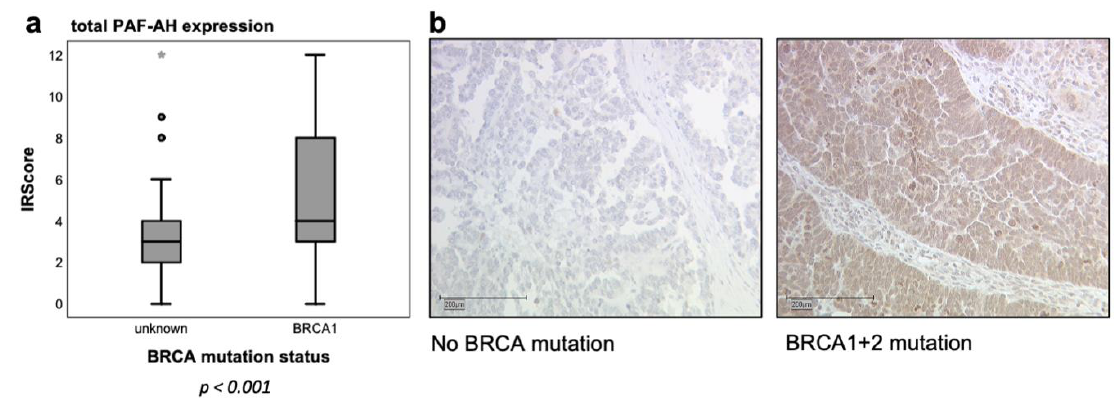
Figure 2. BRCA1 mutation carriers showed higher tumoral PAF-AH expression. PAF-AH expression was significantly higher in tumor tissue of BRCA1 mutation carriers (median IRScore = 4; p < 0.001 indicated by asterisk *; ( a )), when compared (Mann–Whitney U test) to patients with unknown BRCA mutation status (median IRScore = 3). Representative microphotographs of PAF-AH immunostaining of patients with BRCA WT and BRCA1 + 2 mutation are shown on the right ( b ) in 10× magnification (scale bar = 200 µm).